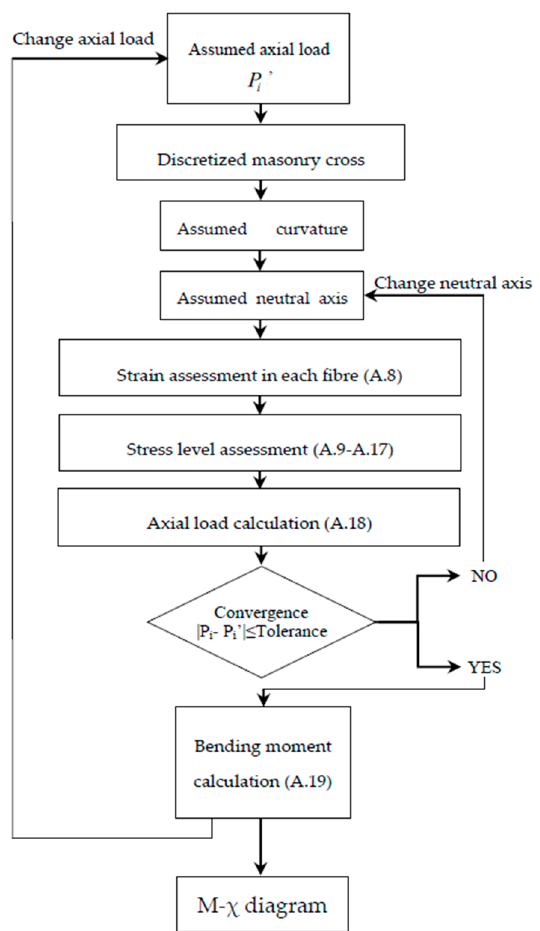
Figure A2. Flowchart of the solver algorithm to assess the bending moment-curvature diagram.